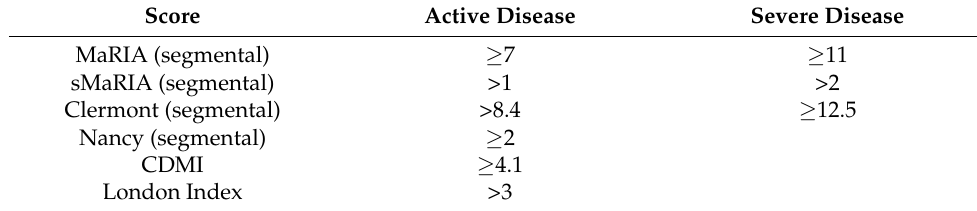
Table 3. Cut-off values for active and severe disease with different MRE